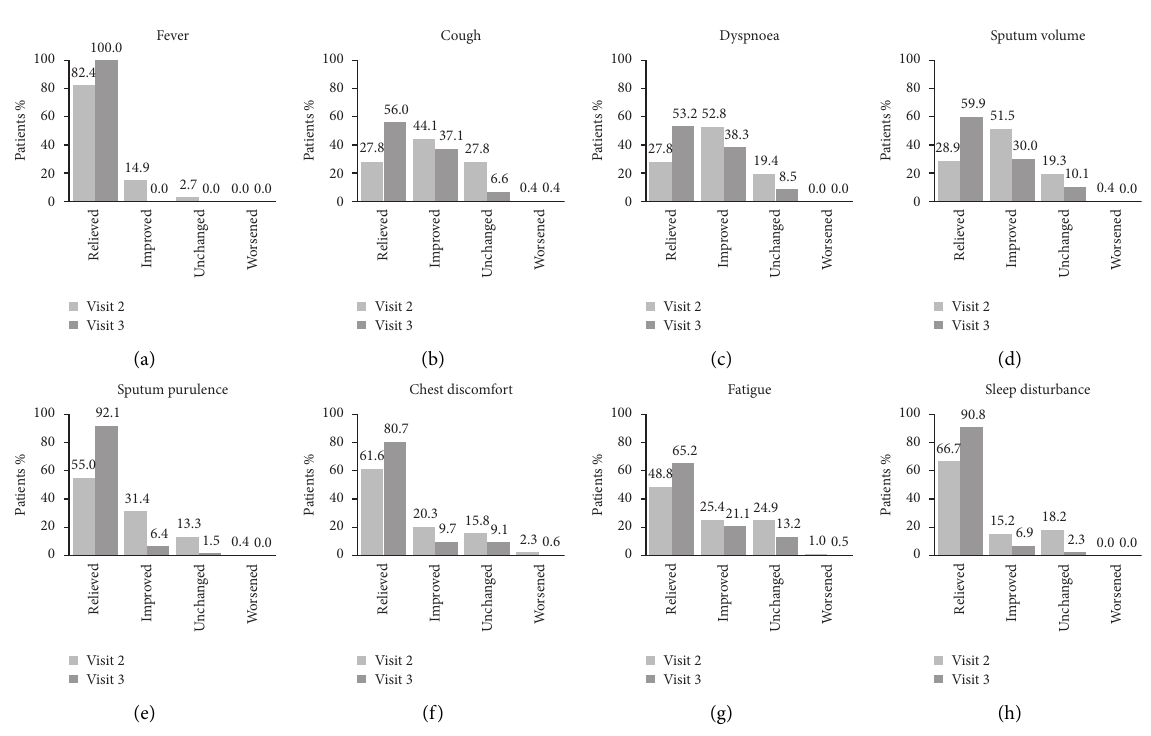
Figure 3: Course of clinical symptoms at visit 2 and visit 3 among patients with symptoms at baseline. Patients with (a) fever, (b) cough, (c) dyspnoea, (d) sputum volume, (e) sputum purulence, (f) chest discomfort, (g) fatigue, and (h) sleep disturbance at baseline whose symptoms were relieved (i.e., switched to absent), improved (decreased intensity), unchanged, or worsened (increased severity) at visit 2 and visit